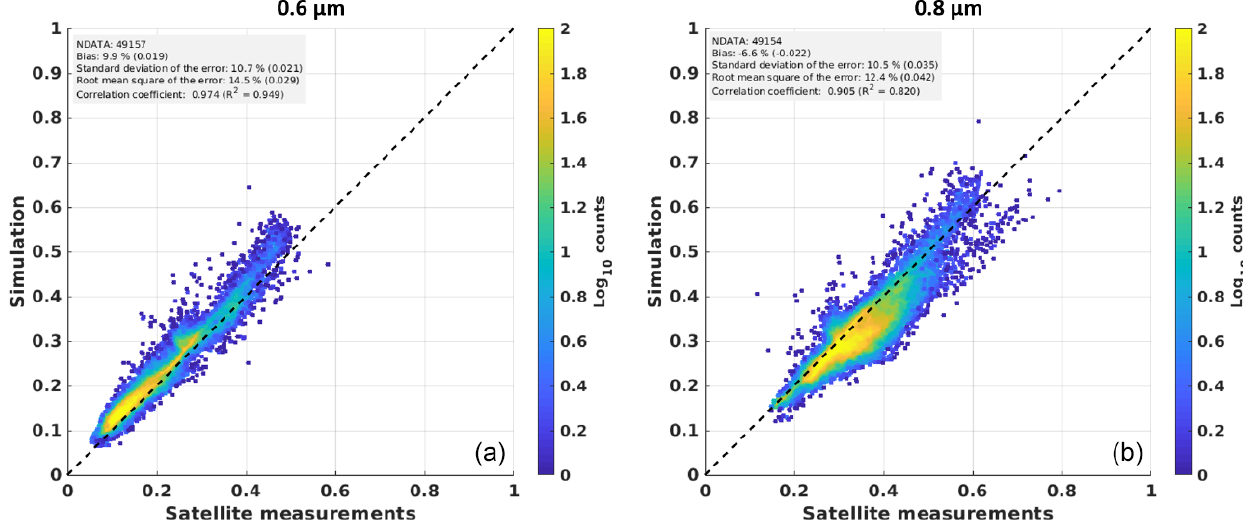
Figure 6. Simulation of clear-sky reflectances at the TOA ( ρ clear ) for MSG 0.6µm (a) and 0.8µm (b) spectral channels compared to actual satellite measurements. Represented data include simulations and measurements for all 11 locations, for the year